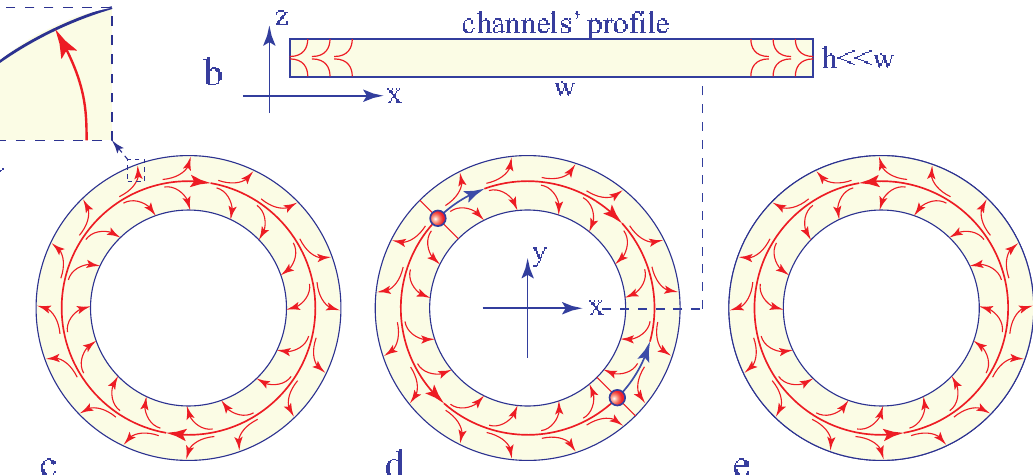
Figure 19. Dowser field in an annular channel. ( a ) Cross section of the channel. ( b ) Homeotropic outward anchoring of the dowser field at the lateral wall of the channel. ( c , e ) Defect-less dowser fields with opposite curls. ( d ) Dowser field in the presence of a dowsons’ pair d+d-. We hope that thanks to the analogy with other systems (f.ex. superconductors) that share with to experts in liquid